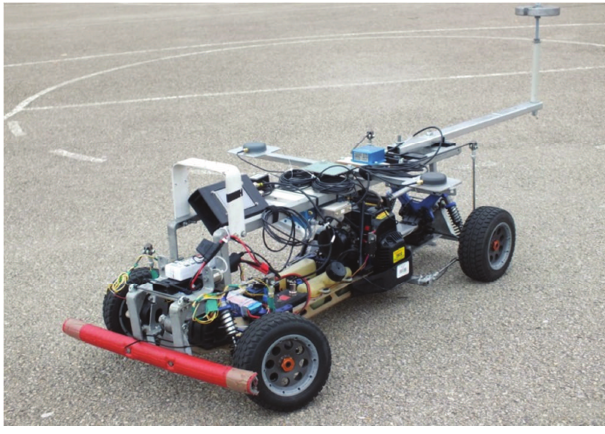
Fig. 1. The measurement equipment mounted on the vehicle in scale In the Department of Internal Combustion Engines and Vehicles of University of Bielsko-Biala was built vehicle in a scale of 1: 5, which has been used to study the vehicles stability. For this purpose, was used the theory of similarity and π -theorem of Buckingham [3,5]. To describe the pa- rameters of the vehicle and its movement were used the dimensionless variables, normalized using the basic units like: length, mass and